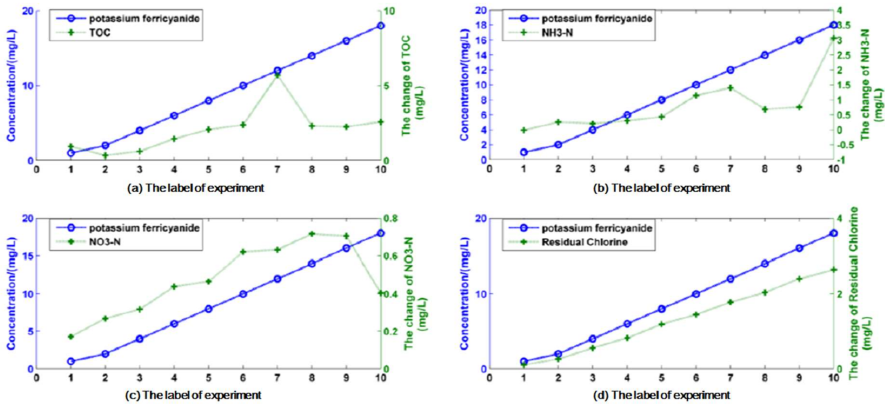
Figure 5. Relative response values of four parameters with concentration of potassium ferricyanide: ( a ) TOC; ( b ) NH 3 -N; ( c ) NO 3 -N; ( d ) residual chlorine